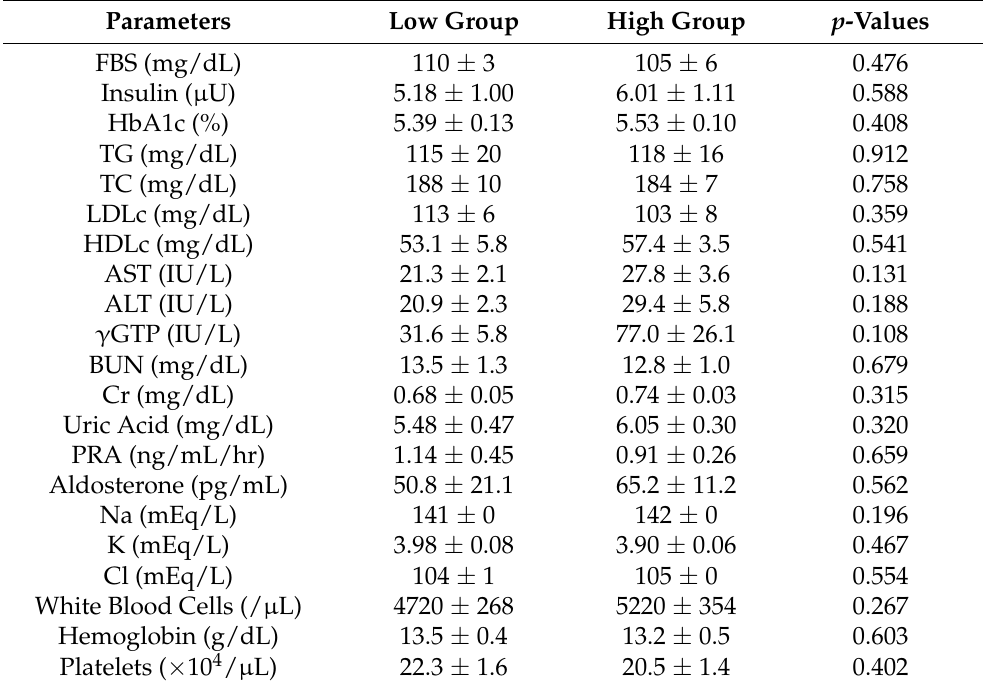
Table 5. Laboratory data for the low urinary AGT group and the high urinary AGT group at the